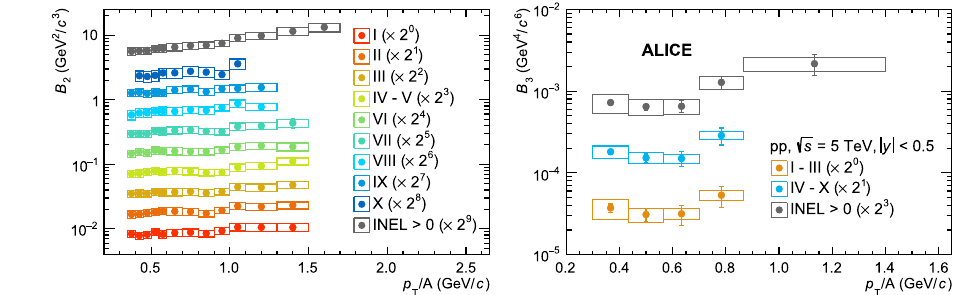
Fig. 3 Coalescence parameters B 2 for (anti)deuterons (left) and B 3 for (anti)helions (right) for different multiplicity classes. The multiplicity decreases moving from the bottom up. The statistical uncertainties are